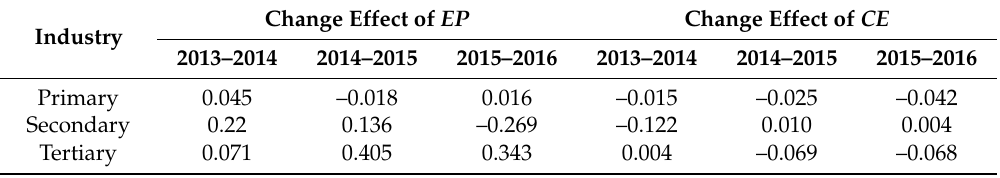
Table 9. Change effect of EP and CE in the industrial structure